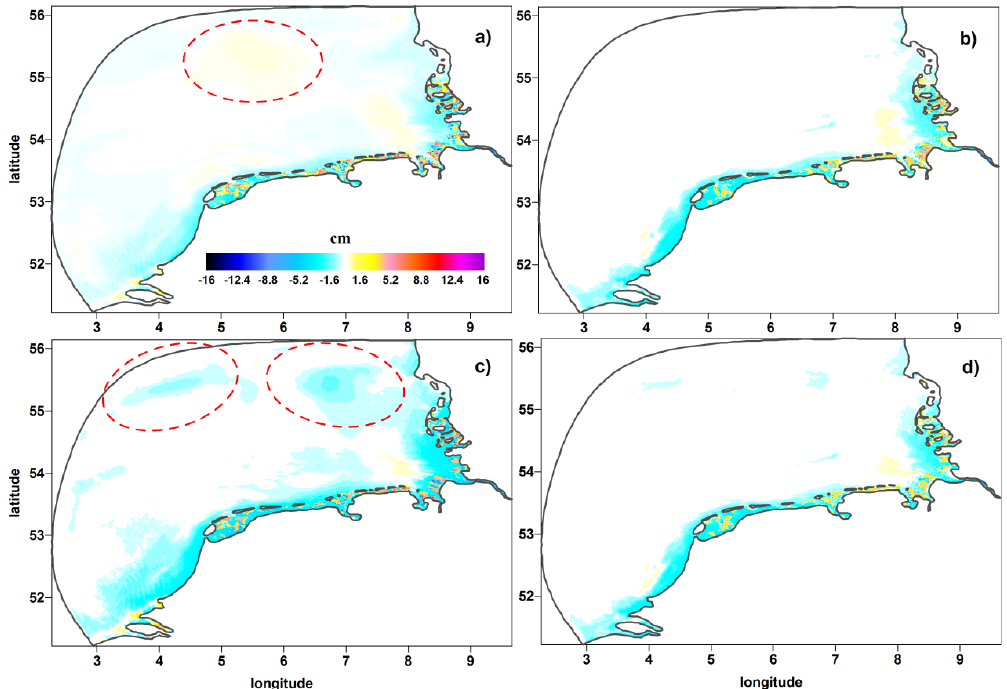
Figure 17. The spatial difference for SSH between solutions on different meshes with different atmospheric scenarios: ( a ) at δζ m 8 − δζ m 5 ; ( b ) at δζ m 5 − δζ m 3 in “weak wind”; ( c ) at δζ m 8 − δζ m 5 ; and ( d ) at δζ m 5 − δζ m 3 in “strong wind”. Red ellipses denote zones of maximum differences in the deep-sea part of the North